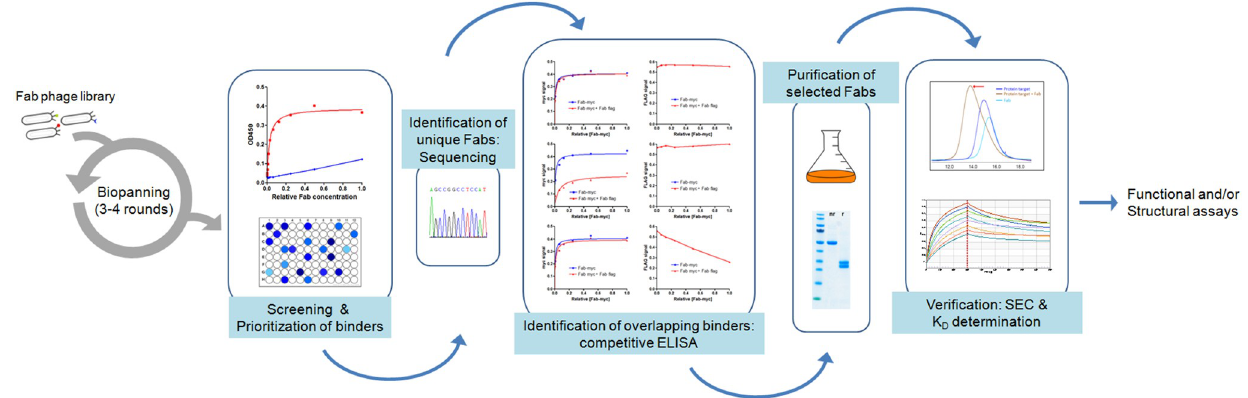
Fig 2. Experimental workflow for antibody selection.